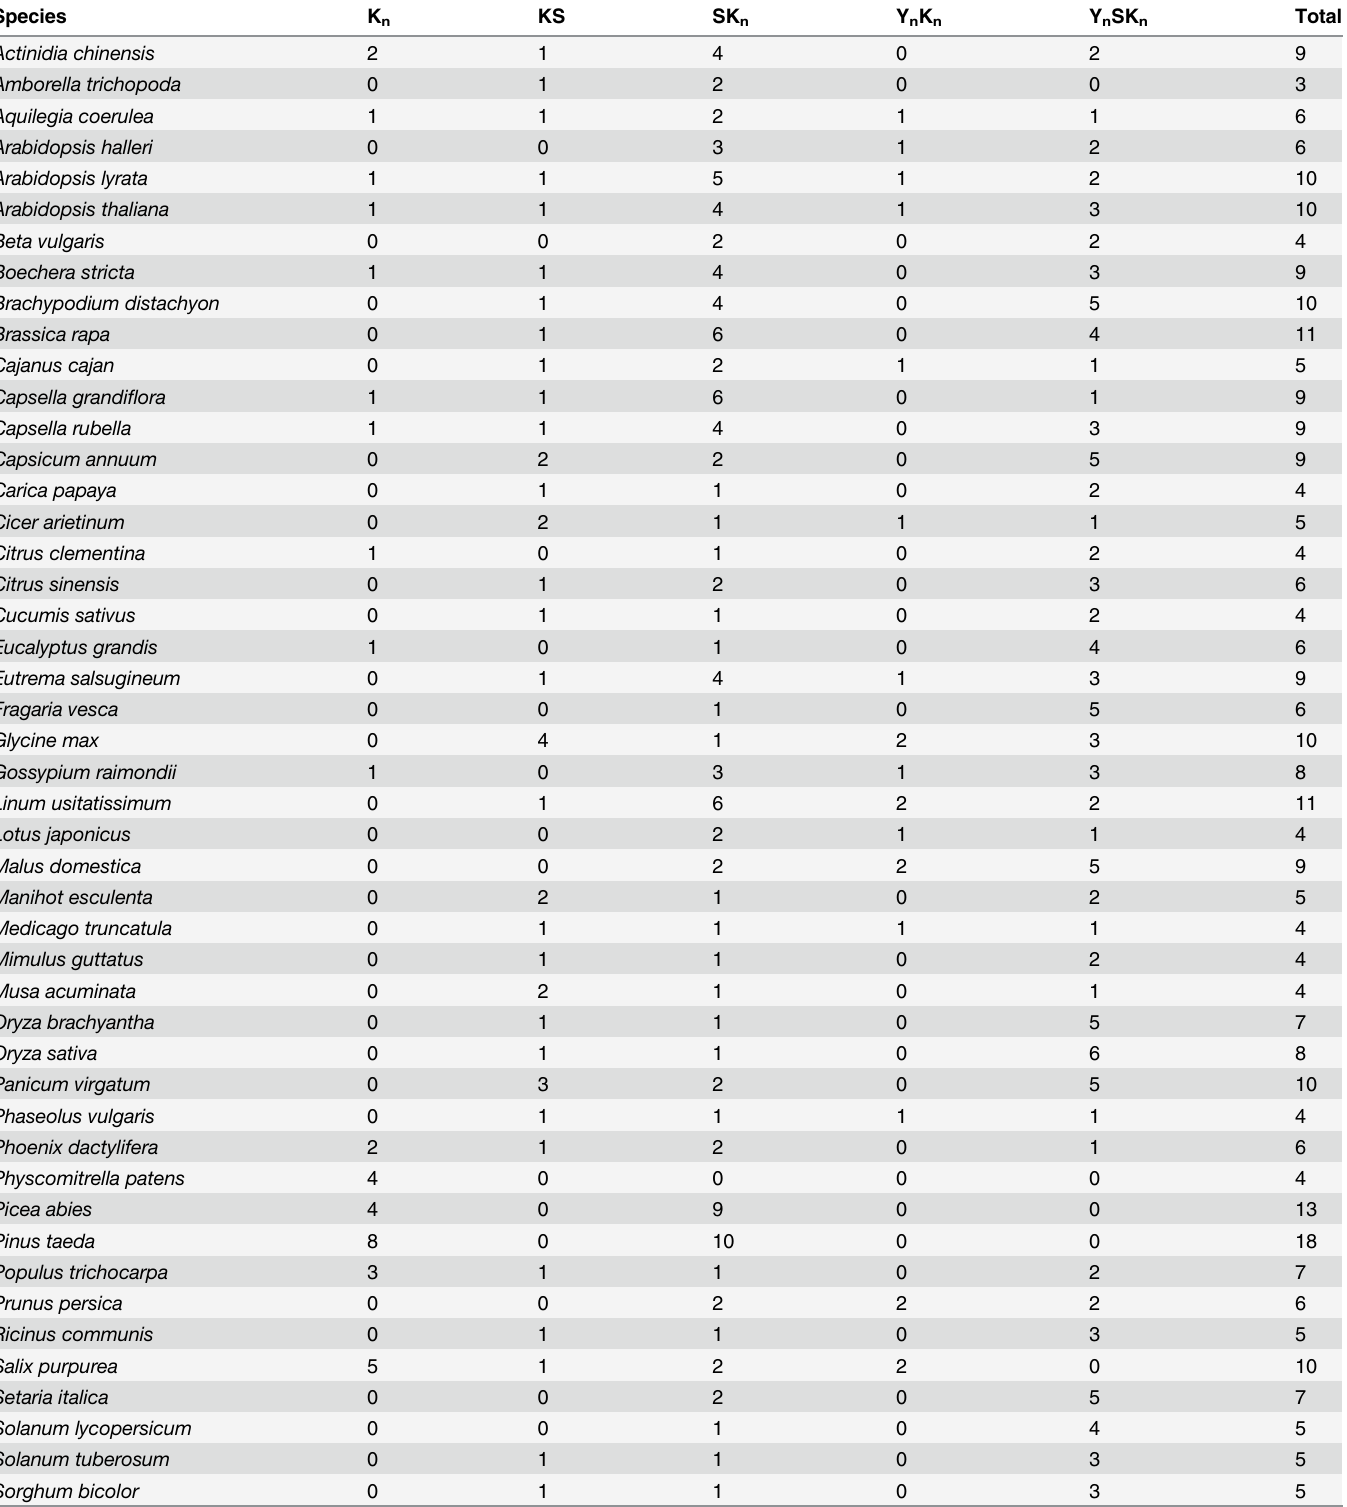
Table 1. Number of analyzed dehydrin promoters per